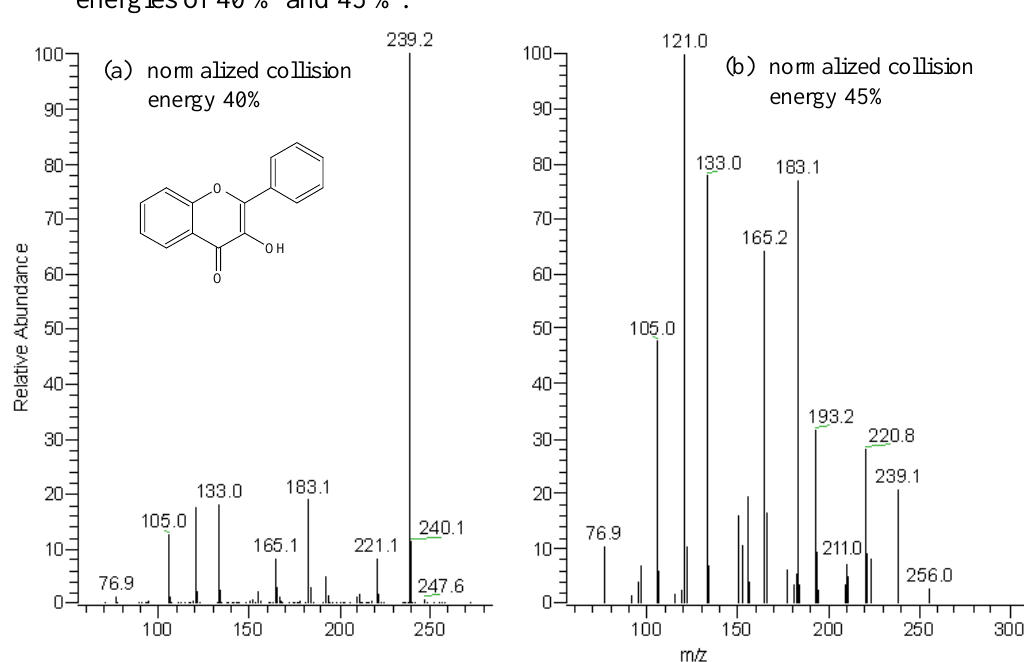
spectrum of flavonol for normalized collision Figure 3. The MS 2 energies of 40 % and 45